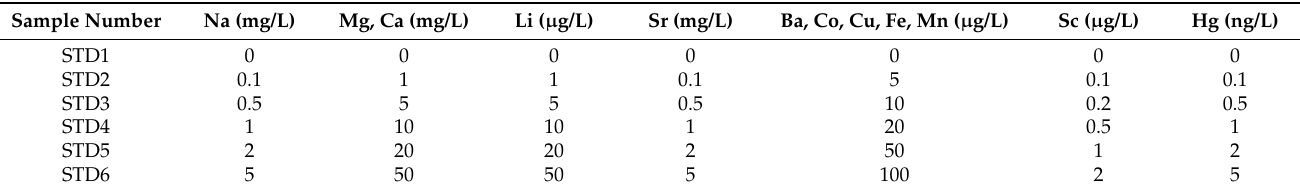
Table 1. Mass concentrations of multi-element mixed standard solution.